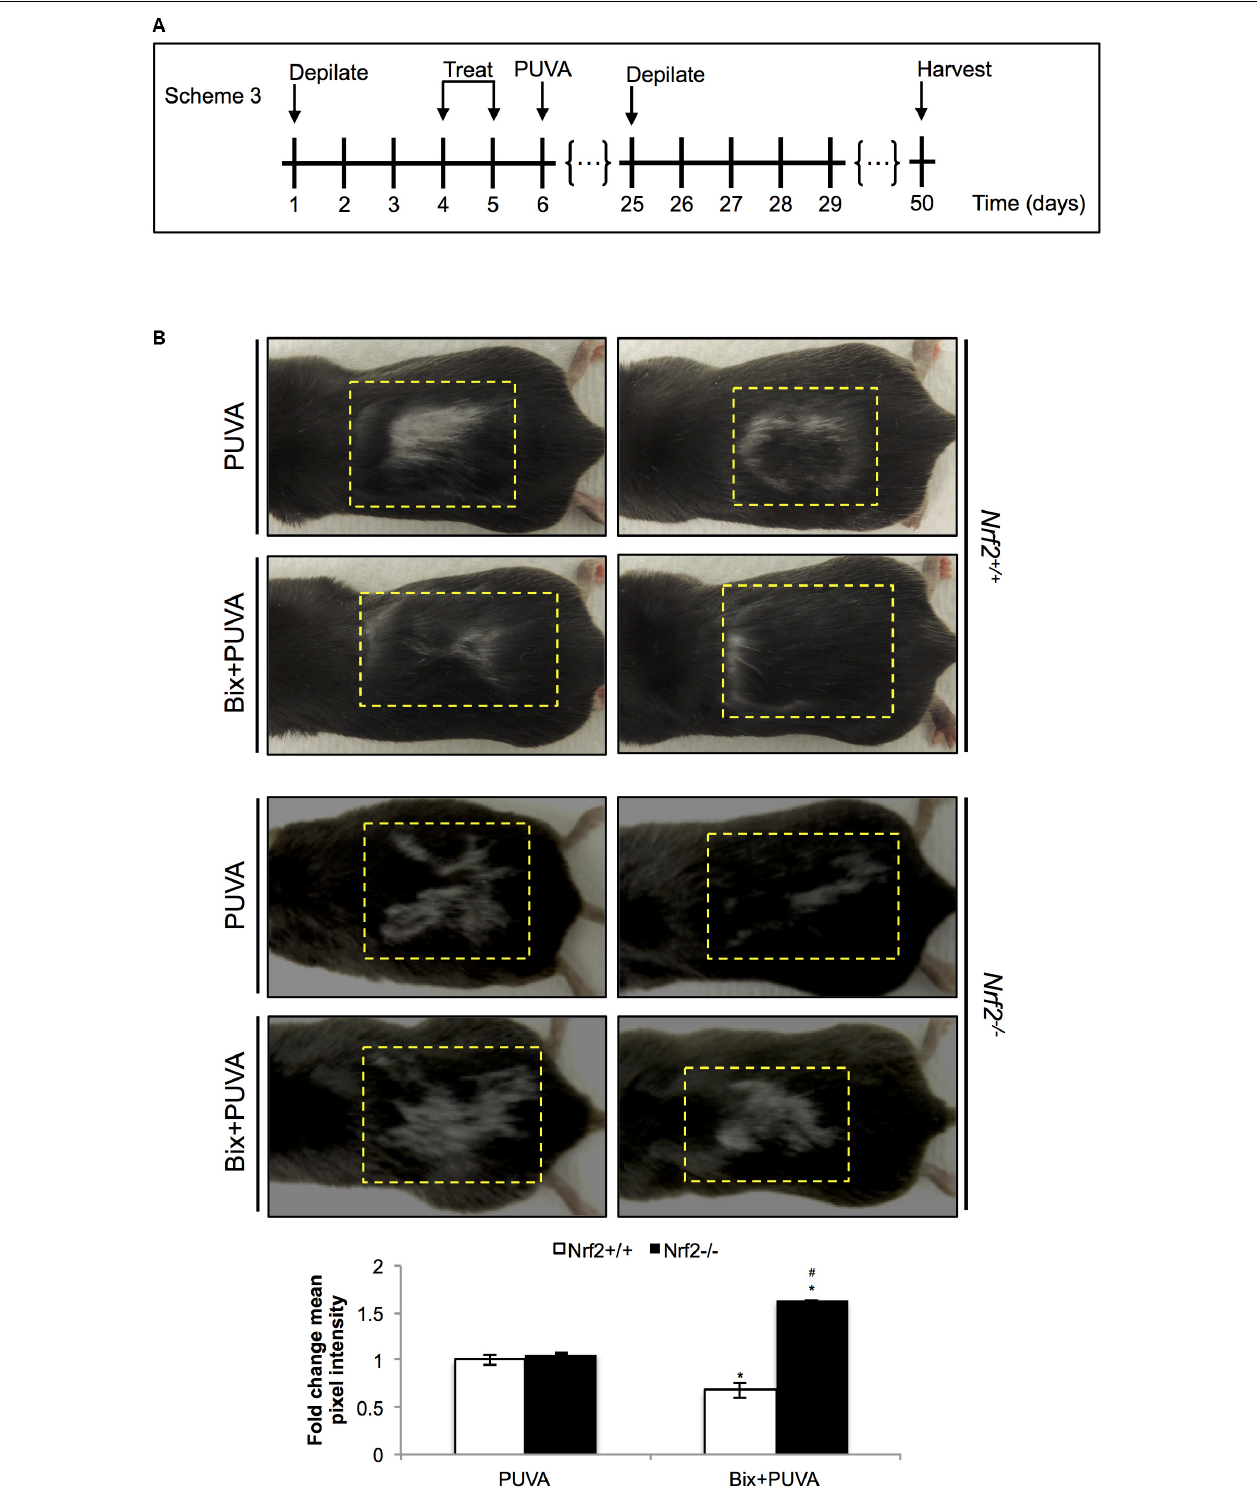
FIGURE 5 | Topical bixin prevents PUVA-induced hair graying in C57BL/6J mouse skin. (A) Treatment scheme for PUVA-induced hair graying study in C57BL/6J Nrf2 + / + and Nrf2 − / − mice. (B) Representative images of PUVA-induced hair graying. The yellow lines delineate the area originally depilated and treated. Mean pixel intensity (whiteness) was calculated per treatment area, normalized, and expressed as fold change to Nrf2 + / + PUVA values. p < 0.05: ∗ compared to Nrf2 + / + PUVA, # compared to Nrf2 + / + Bix +